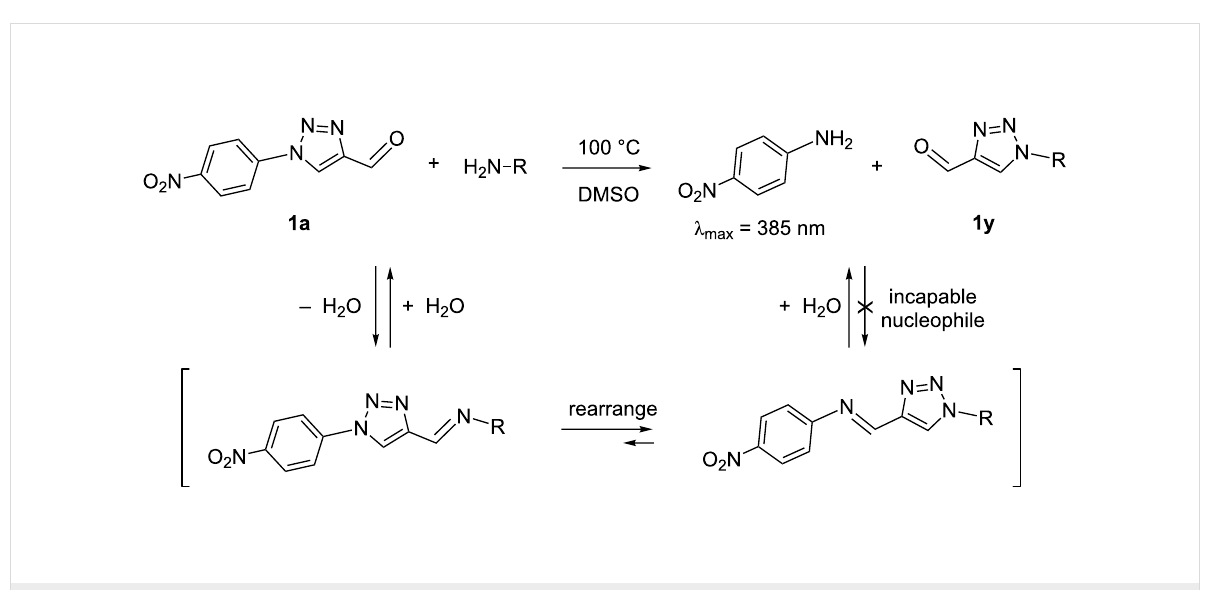
Figure 4: Rearrangement reaction progress of 1a leading to irreversible formation of a colorimetric self-indicating byproduct.